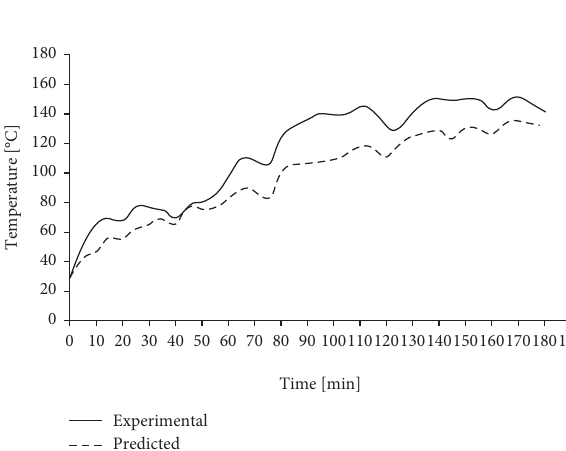
Figure 5: Hot plate surface temperature for the experimental and predicted